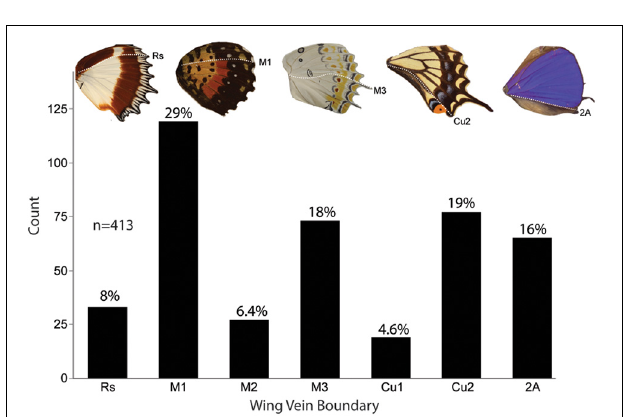
FIGURE 7 | Frequency of anterior–posterior color pattern heterogeneity across five butterfly families. A total of 201 genera from five families were found to have anterior–posterior color pattern discontinuities. Several genera were counted more than when they had color dislocations at multiple boundaries on the same wing for a total count of 413 individuals. Across the specimens surveyed, a color boundary at M1 (29%) occurred most frequently followed by Cu2 (19%) and M3 (18%). These data show that color pattern discontinuities occur most frequently at expression domain